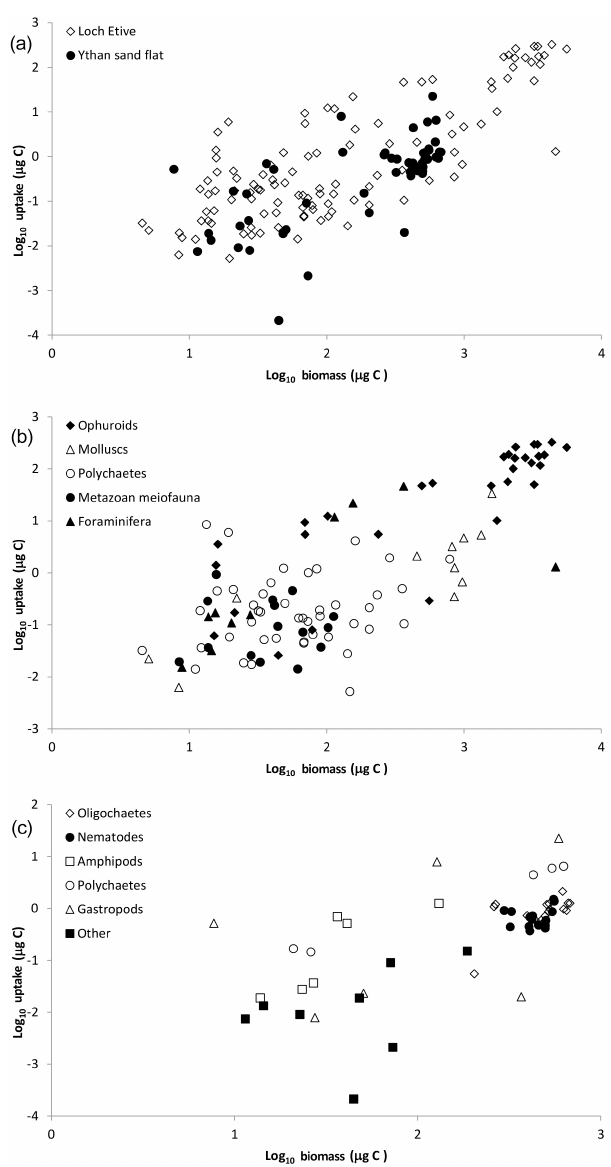
Figure 4. Log 10 uptake against Log 10 C biomass for (a) all speci- mens analysed in Loch Etive and on the Ythan sand flat, (b) Loch Etive with taxonomic detail, and (c) the Ythan sand flat with taxo- nomic